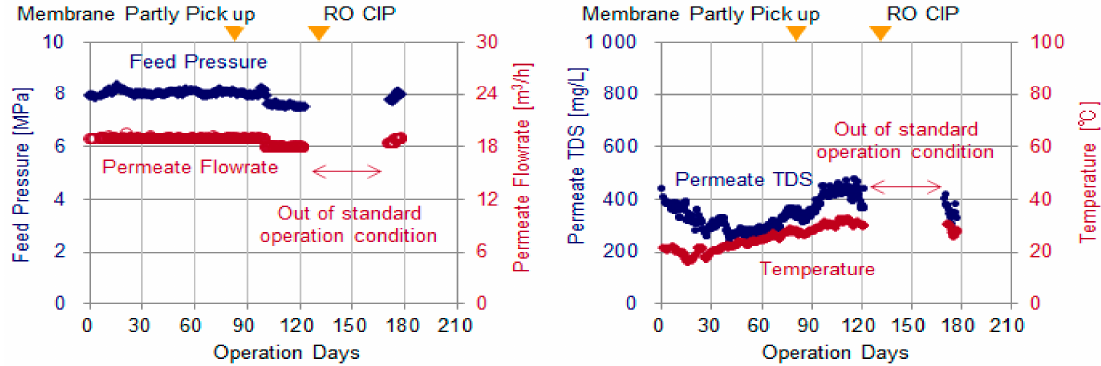
Figure 9. Changes in feed pressure, permeate flowrate, Total Dissolved Solids (TDS) and temperature.